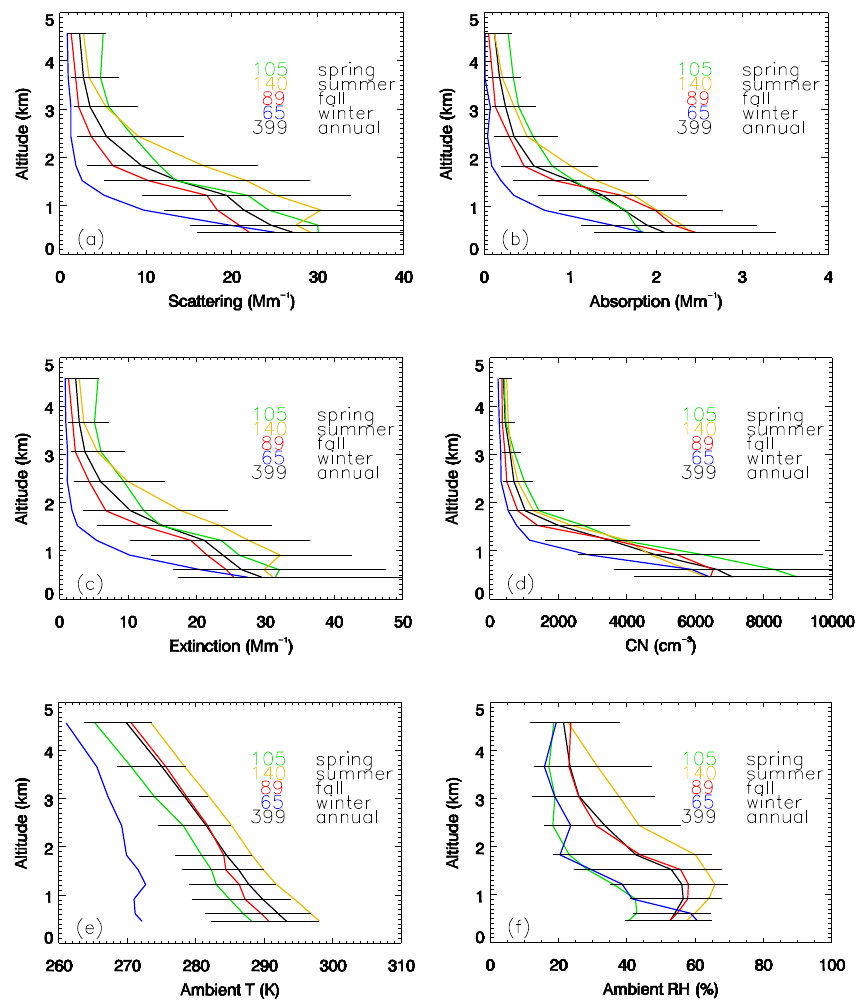
Fig. 10. Median seasonal profile plots of AAO measurements. Black profile in each plot represents all aircraft profiles. Horizontal bars show the extent of the 25th and 75th percentiles of the total distribution.